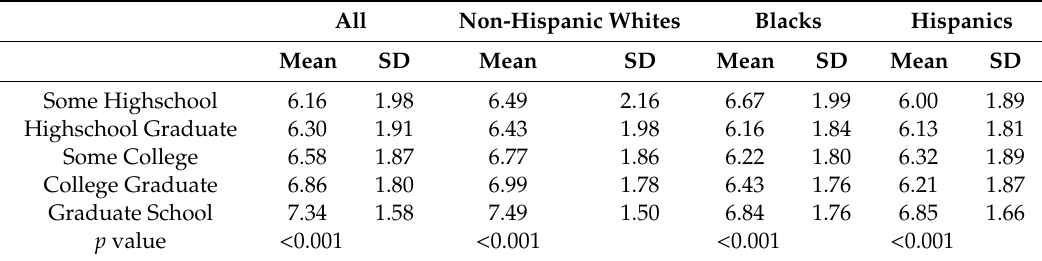
Table 3. Analysis of variance (ANOVA) results overall and by